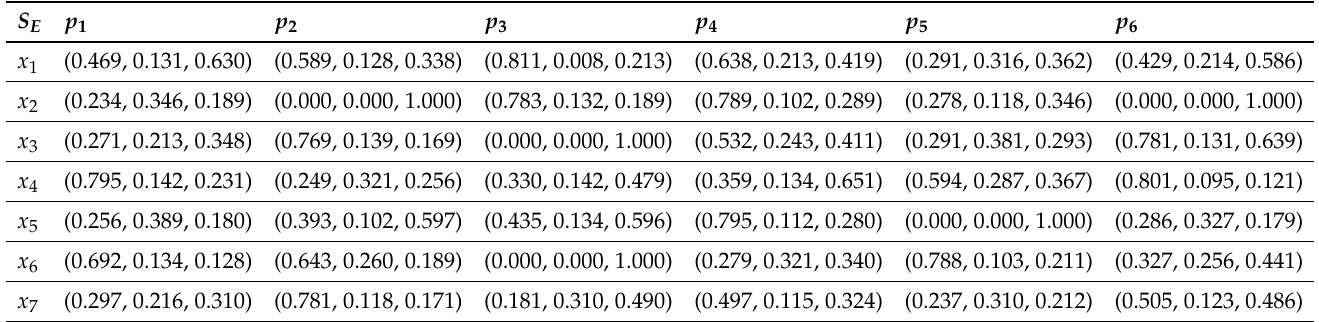
Table 3 shows the decision maker’s assessment of alternatives under the influence of parameters in terms of SFSS S E . Table 3. SFSS evaluation by the decision